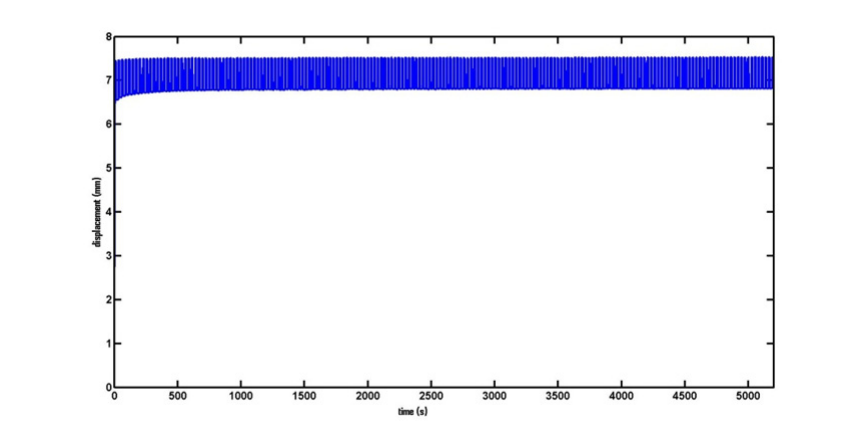
Fig. 7 Full test with a hold time of 5 seconds at maximum and 20s at minimum